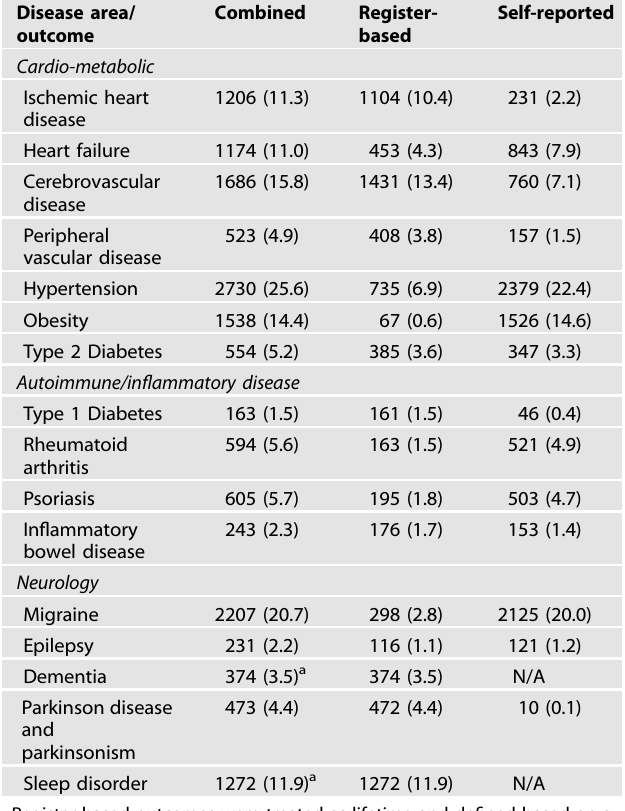
Table 1. N cases and % prevalence of lifetime evaluated somatic health outcomes ( N =